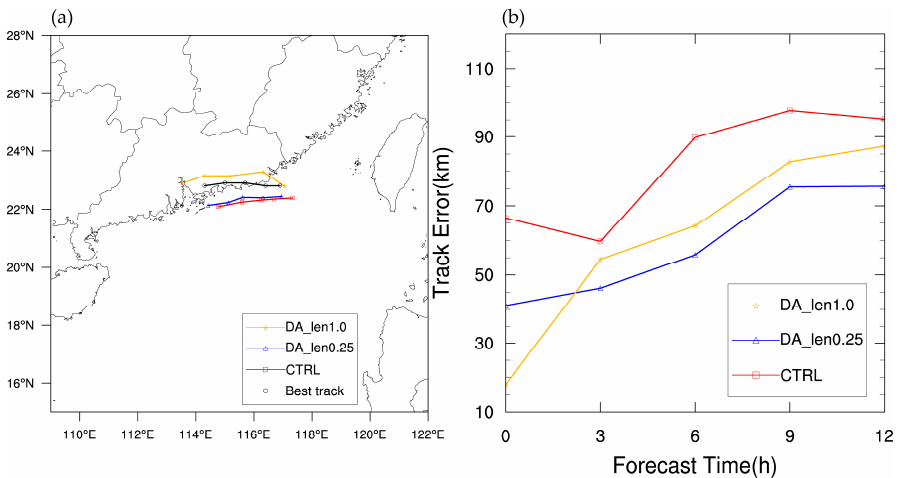
Figure 11. ( a ) Forecast tracks in the three experiments and the CMA’s best track; ( b ) track errors (unit: km) of the three experiments compared to the CMA’s best track during the forecast period.